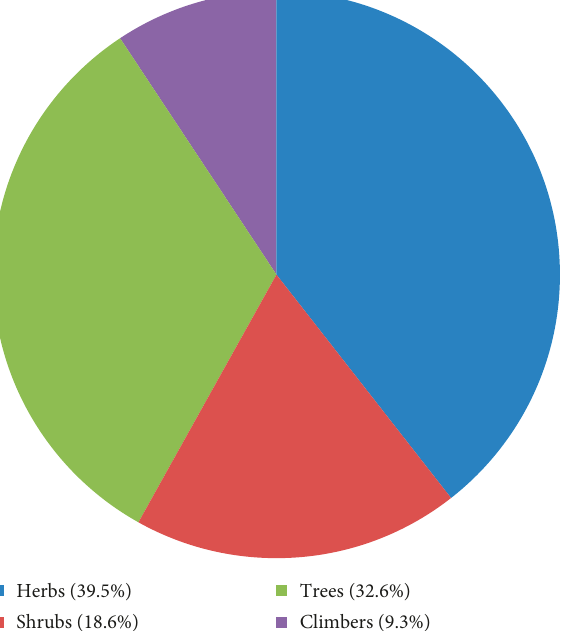
Figure 2: Life form of the plants used as anti-inflammatory